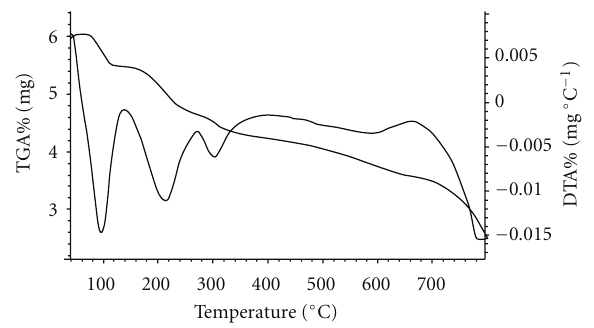
Figure 1: TGA Spectrum of [Ni(1,10-phen)(MIIMP)(H 2 O) 2 ]Cl.